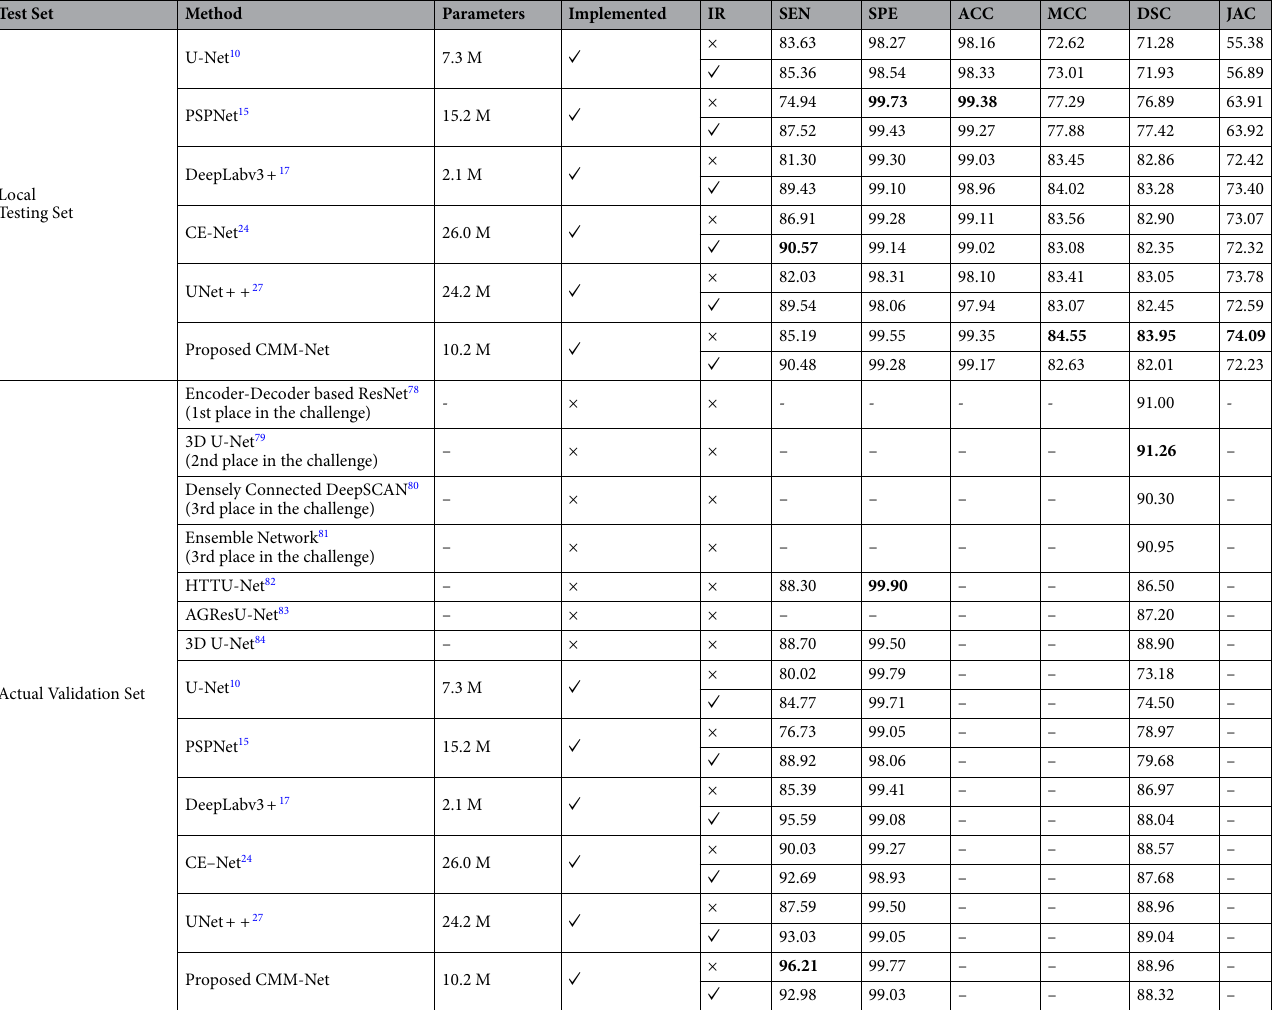
Table 5. Brain tumors segmentation performances (%) via the proposed CMM-Net compared to the recent deep learning approaches. HTTU-Net: Hybrid Two Track U-Net; and AGResU-Net: Attention Gate Residual